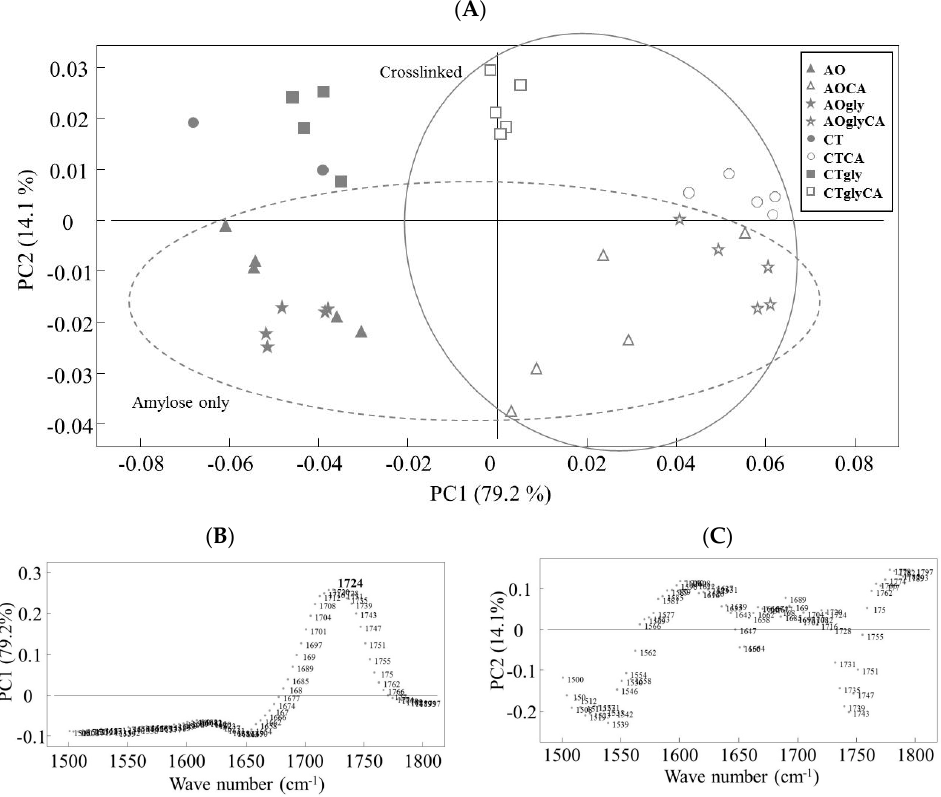
Figure 2 . Principal component analysis (PCA) on Multiplicative Scatter Correction pre-processed Fourier Transform Infrared Spectroscopy spectra (1800–1500 cm − 1 ) obtained from analysis of extrudates. ( A ) Score plot of PC1 vs. PC2. Samples are grouped according to both starch type and CA a cross-linking; ( B , C ) loading plots of PC1 and PC2, respectively. The peak arising from carboxyl and ester carbonyl absorbance (1724 cm − 1 ) is highlighted.